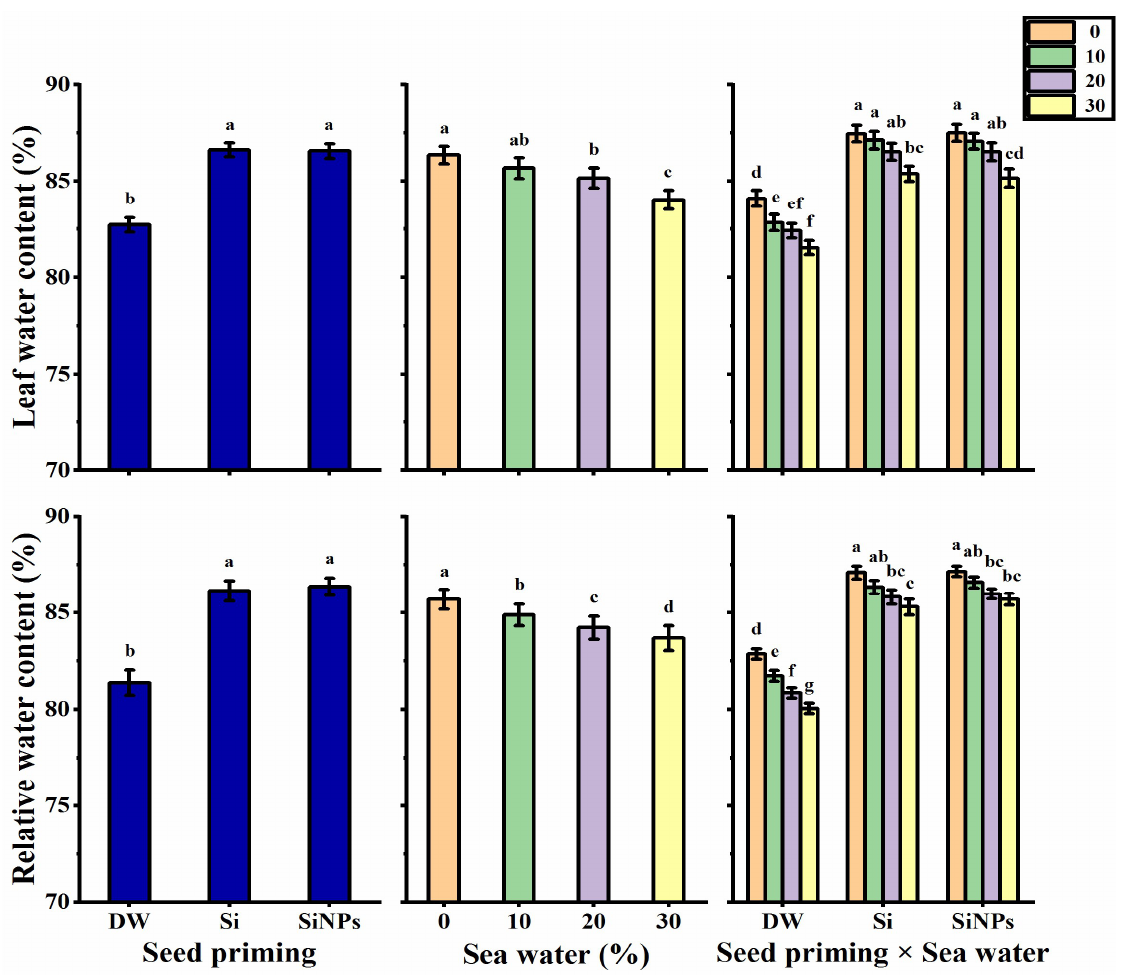
Figure 3. Effect of seed priming on leaf water content (%) and relative water content (%) of Lathyrus odoratus leaves irrigated with seawater levels (0, 10, 20, and 30%). Data are mean value ± SE. Bars with different letters are significantly different at p ≤ 0.05 level.